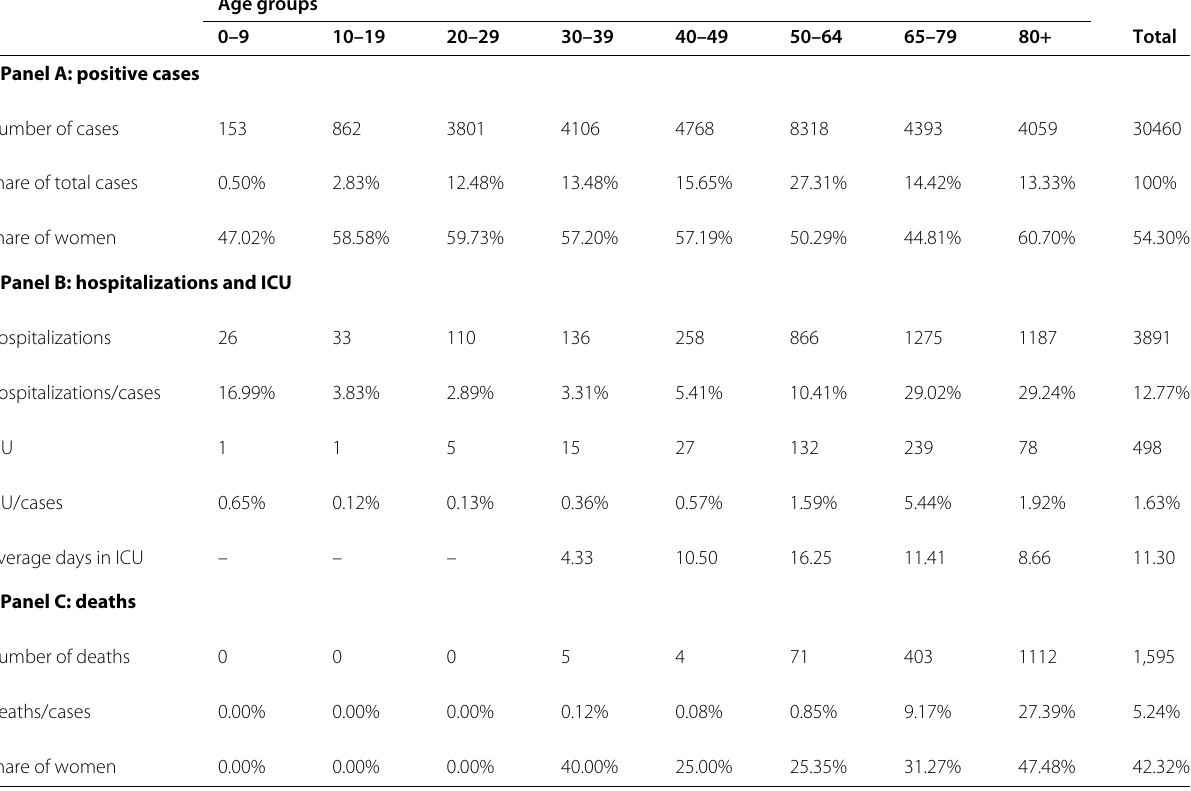
Table 1 Descriptive statistics by age group (by May